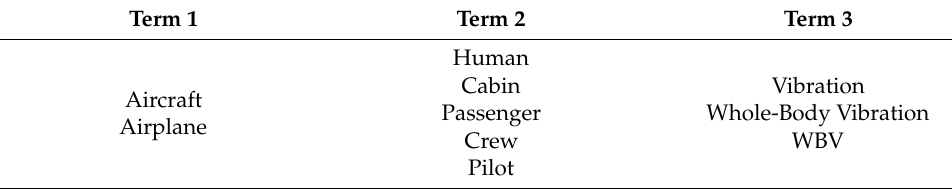
Table 1. Search terms used in SCOPUS, Web of Science, and Google